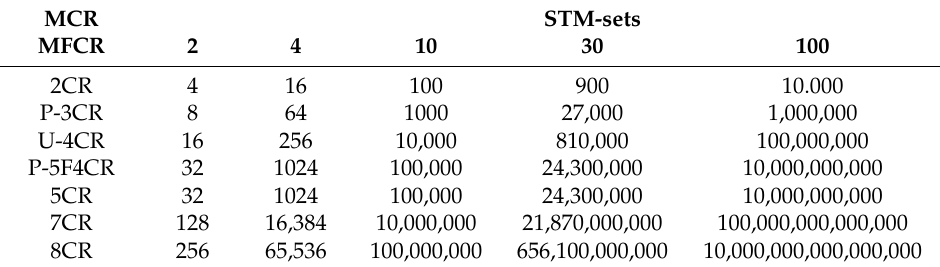
Table 5. Calculated products as function of component C or function F numbers in MCRs.